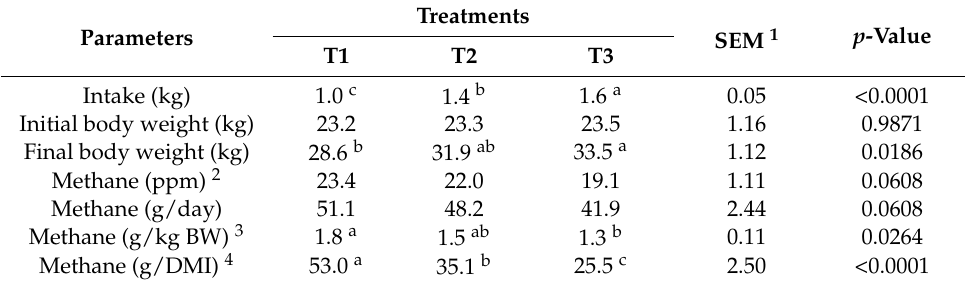
Table 1. Effects of supplementing barley sprouts on methane emission of meat-master lambs.